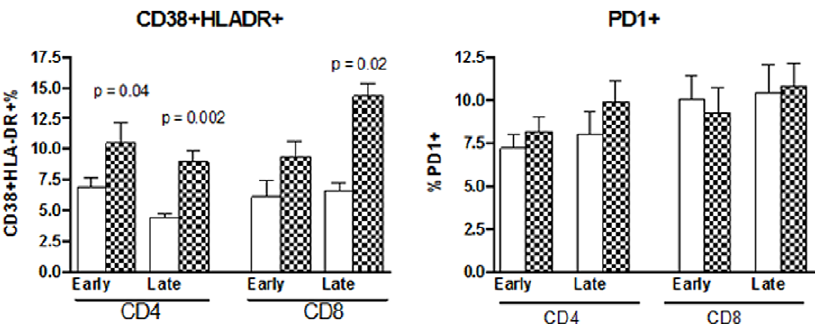
Figure 4. Proportions of Tact in HIV-infected and uninfected women during early and late gestation. Bars indicate mean and SEM proportions of the Tact subpopulations indicated in the title of each graph. Tact are expressed as percentages of the parent CD4 + or CD8 + T cell populations. Significant differences between HIV-infected and uninfected women are indicated by p values immediately above each time point (Mann Whitney test).